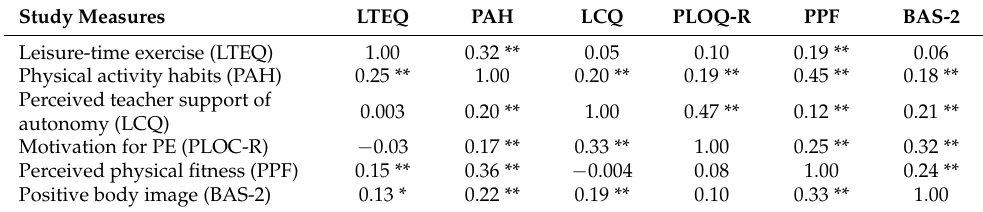
Table 2. Correlations between study measures in boys and girls (n =